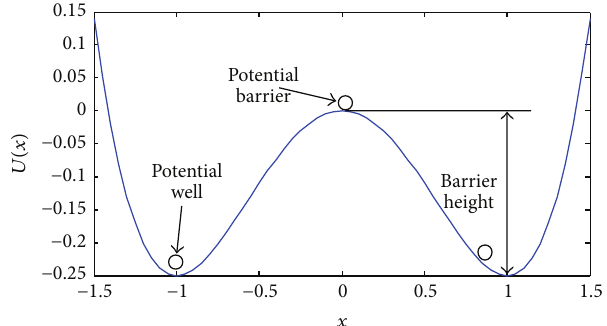
Figure 1: The bistable state function curve ( 𝑎 = 𝑏 = 1, 𝐴 = 0 ).